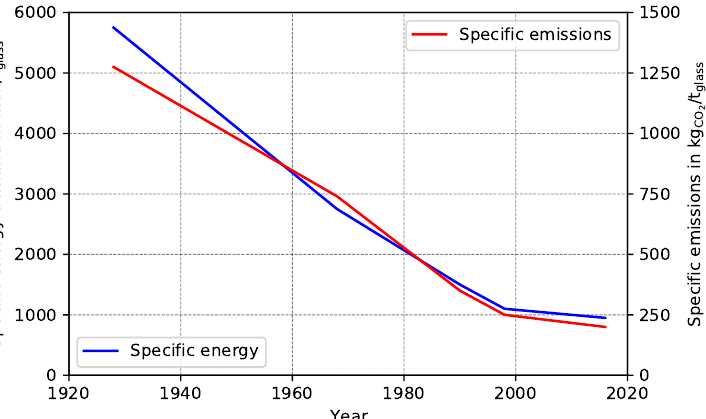
Figure 1. Historical development of specific energy demand and specific CO 2 emissions based on data from the glass industry in the EU across the overall glass sectors (e.g., glass fibers, container glass, special glass). Adapted with the permission of Ref. [7]. Copyright 2017